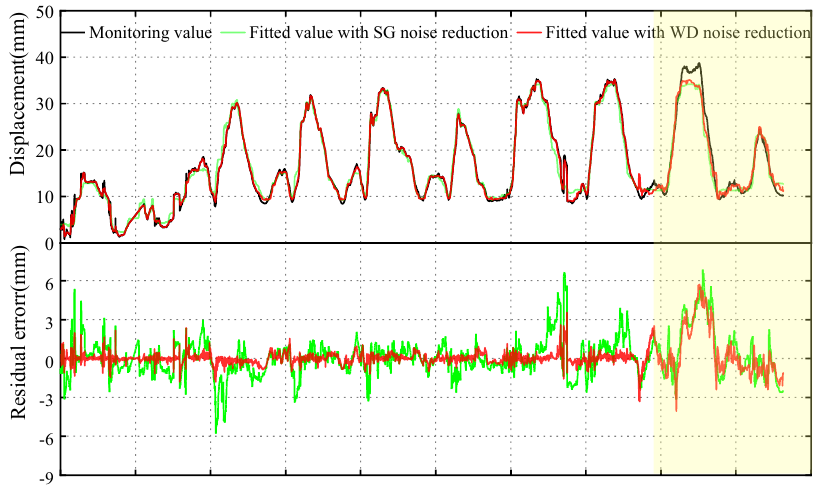
Figure 8. The displacement and residual error plot with Savitzky-Golay de-noising or wavelet de-noising on A09-PL-01.